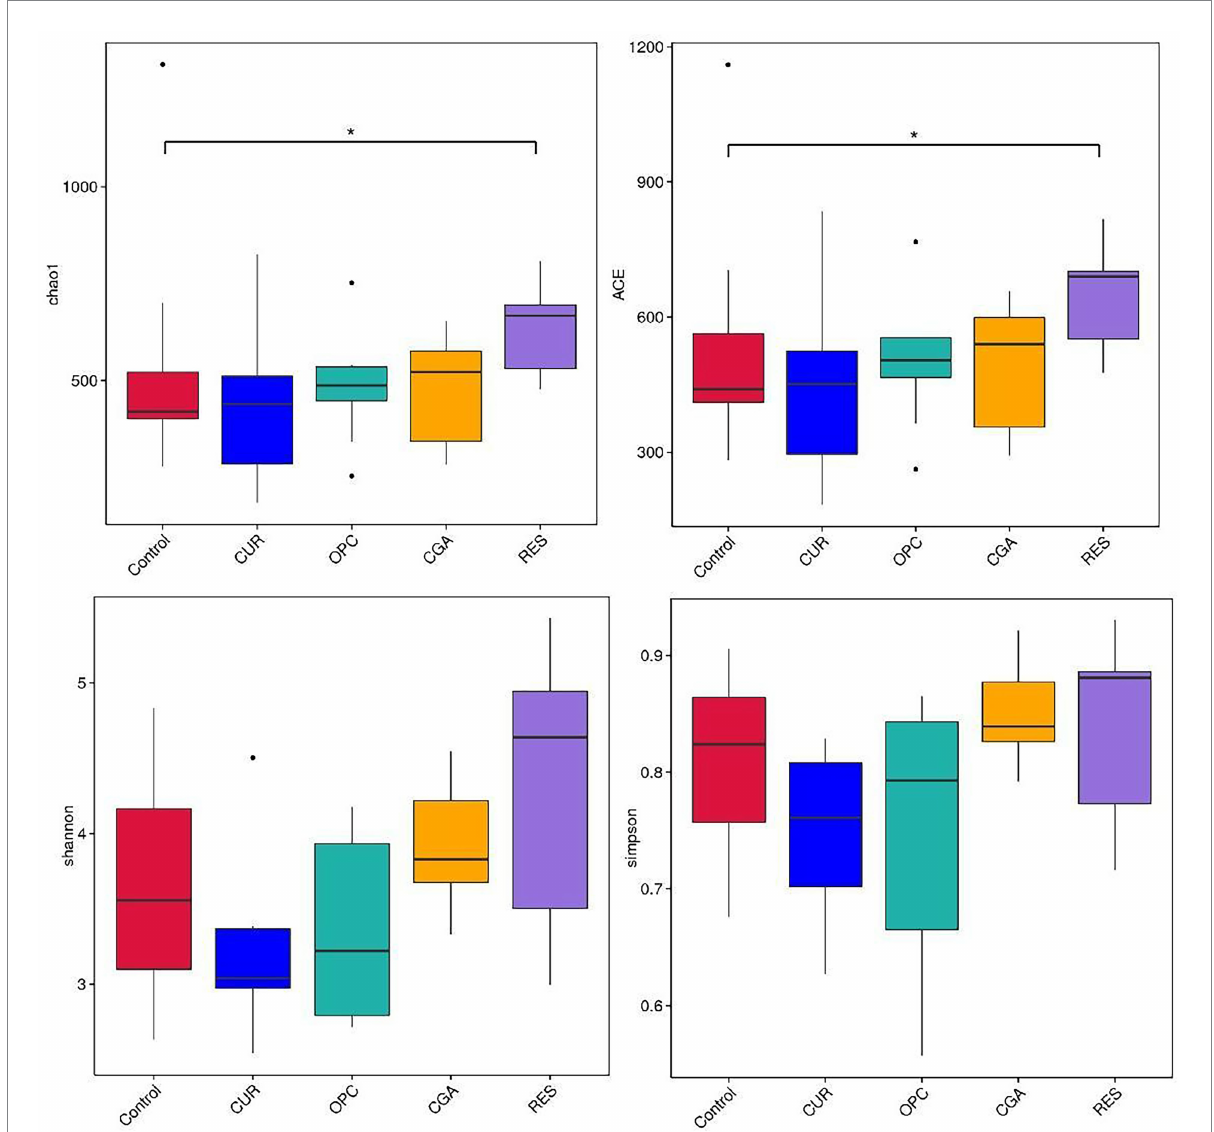
FIGURE 6 Alpha-diversity indices of gut bacterial community ( n = 9 per treatment). CON, control group; CUR, curcumin group; OPC, oligomeric proantho cyanidins group; CGA, chlorogenic acid group; RES, resveratrol